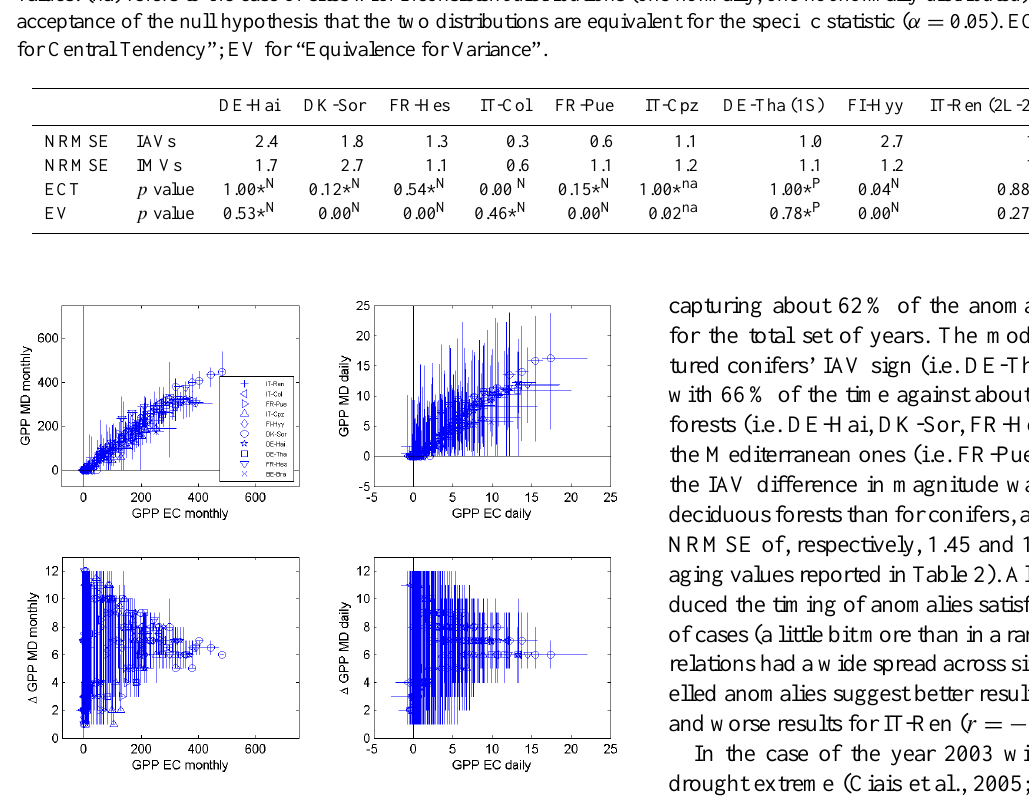
Figure 6. Comparison between GPP MD and GPP EC data. The top plots show the average GPP EC : GPP MD correlation for (left) monthly (gCm − 2 month − 1 ) and (right) daily (gCm − 2 day − 1 ) data. The bottom plots show absolute difference range between GPP MD and GPP EC while increasing GPP EC values. Negative val- ues are excluded because of model assumptions. DE-Tha refers to the 1S simulation, IT-Ren to the 2L_2C simulation, BE-Bra to the P_Q-3L simulation (see